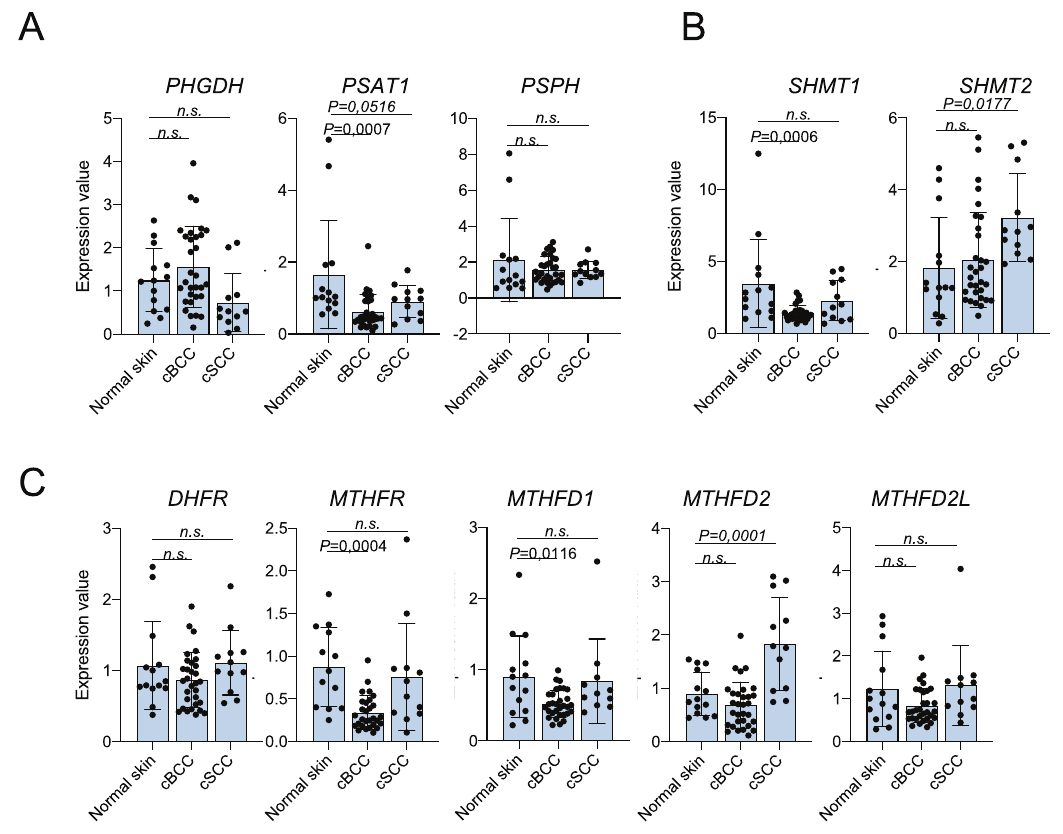
Fig. 1 Expression analysis of serine de novo biosynthesis, serine anabolism/catabolism and one-carbon metabolism enzymes in human samples of normal skin, cBCC and cSCC. A Expression analysis through RTqPCR of serine biosynthesis, B SHMT1 and SHMT2 and C one-carbon metabolism enzymes in a cohort of human samples collected from IDI-IRCCS -normal skin ( n = 14), cBCC ( n = 31), cSCC ( n = 12). The p -value was obtained using Student ’ s t test. Values were considered signi fi cant when the p -value < 0.05, n.s. not signi fi